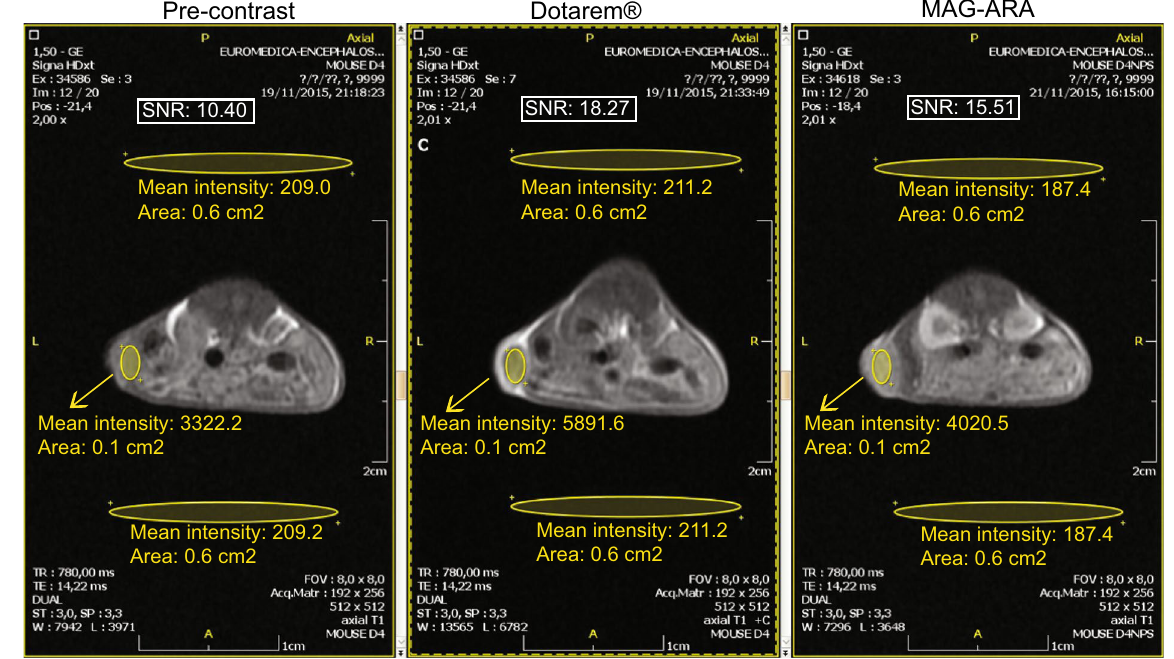
Figure 3. T1 sections of NOD/SCID mice grafted with MDA-MB-231 cells which were MRI-scanned before (Pre-contrast) and after intravenous administration of a commercial contrasting agent (Dotarem) or MAG- ARA NPs. SNR: signal-to-noise ratio. Oval areas represent ROIs used for SNR